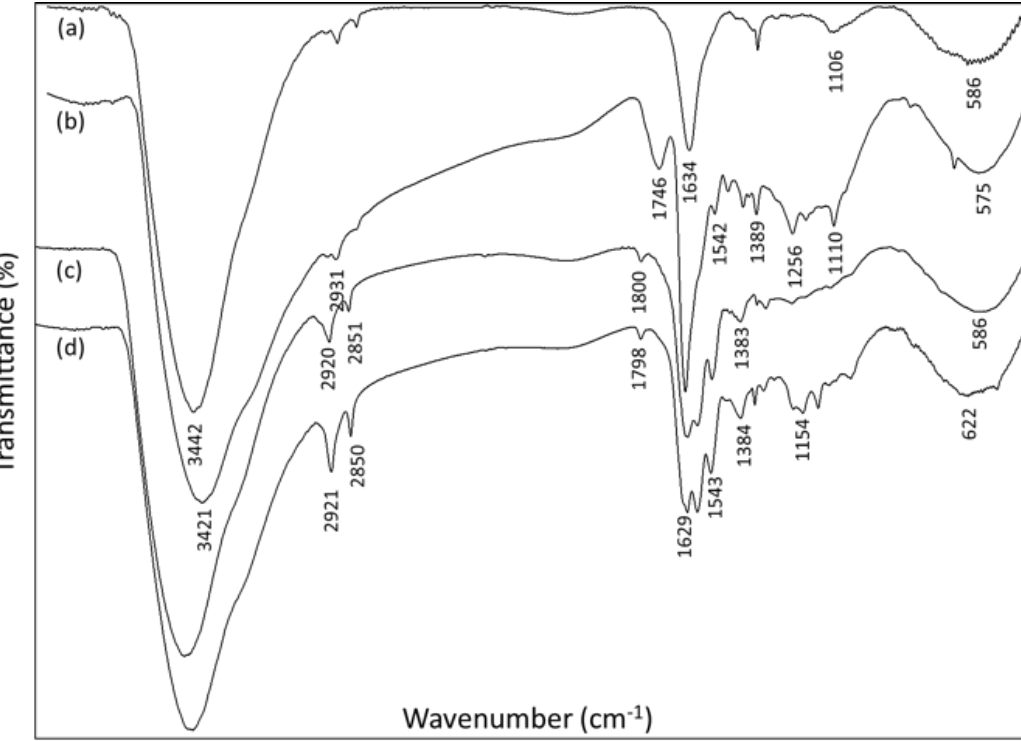
Figure 4. FTIR of ( a ) non-functionalized nanodiamonds, ( b ) ND-SQ1, ( c ) ND-SQ2, and ( d ) ND-SQ3.